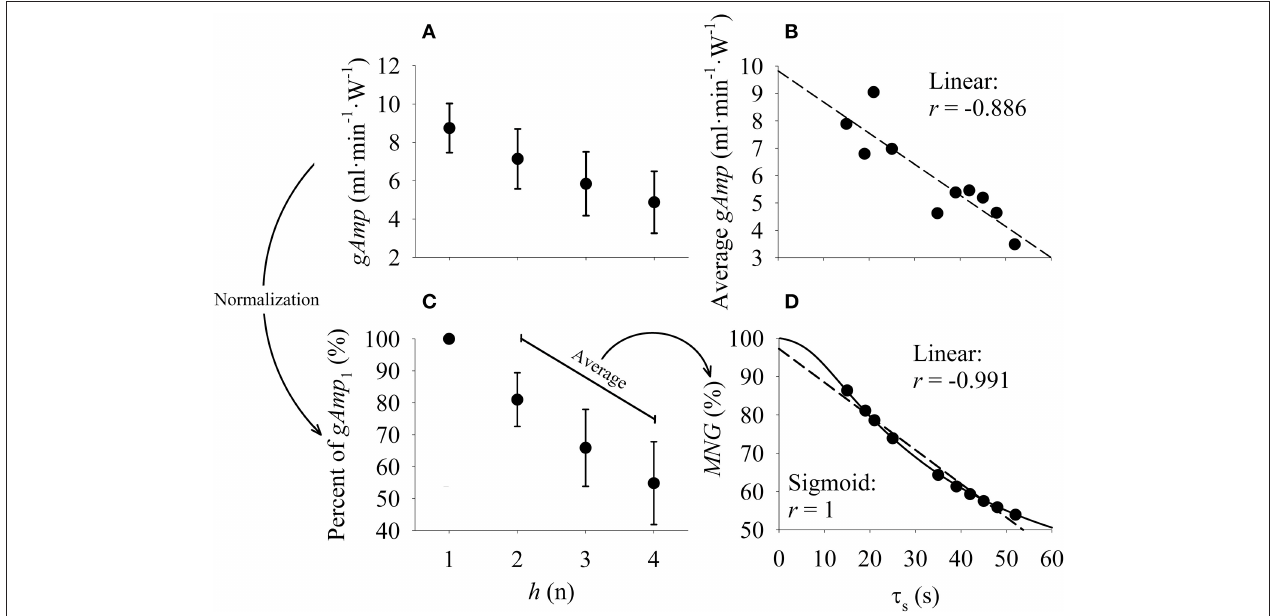
FIGURE 2 | (A) Mean ± SD of 10 simulations of the system gain ( gAmp ) calculated in the frequency domain from data generated using 10 different values of system time constants ( τ s ), amplitudes and baselines (see Table 2 ). (B) linear (– –) relationship between τ s and the average absolute oxygen uptake gain at each tested harmonic ( h ) for each of the 10 simulations. (C) mean ± SD of data displayed in A normalized by the gAmp at h 1 . The mean normalized gain ( MNG ) was calculated as the mean of the gAmp between h 2 , h 3 , and h 4 (please see text and Equation 4). (D) relationship between τ s and MNG . This relationship was fitted by a linear (– –) and sigmoid (–) function. Notice in (D) that the normalization procedure isolated the relationship between amplitude and τ s from other sources of system distortion such as system gain and baseline. The correlation coefficient “ r ” was used to indicate the degree of correlation between τ s and MNG . Please see text for further details regarding the sigmoid